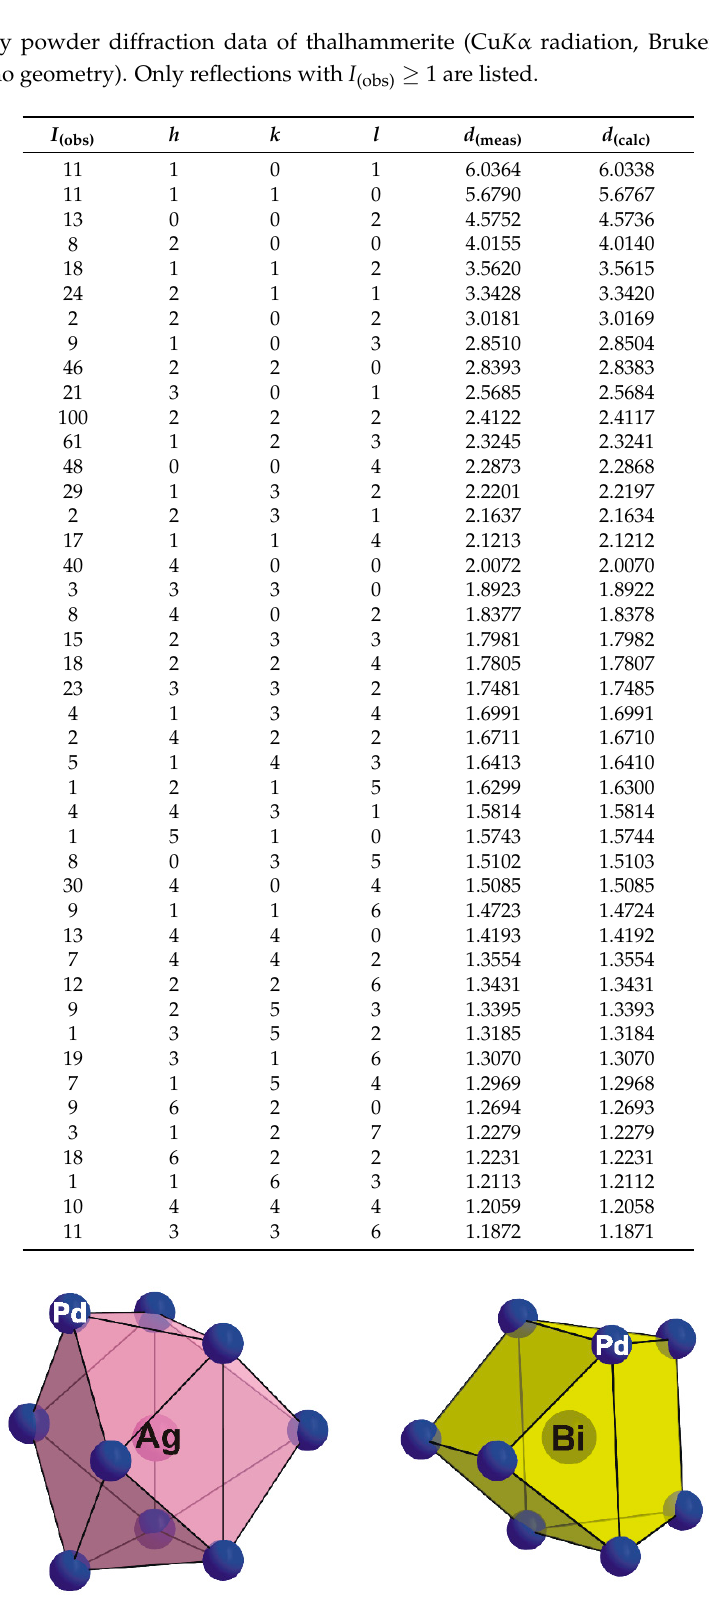
Figure 5. Coordination polyhedra of Ag (mono-capped tetragonal antiprism) and Bi (bi-capped trigonal prism) in the thalhammerite structure.